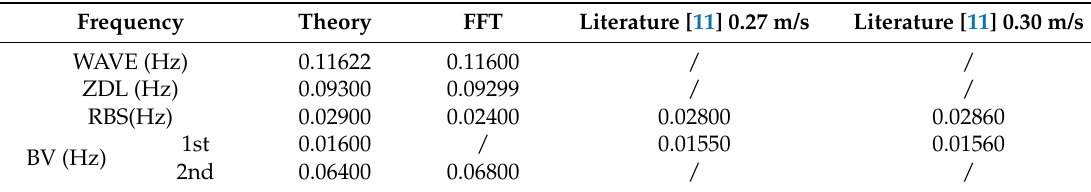
Table 4. Load excitations of